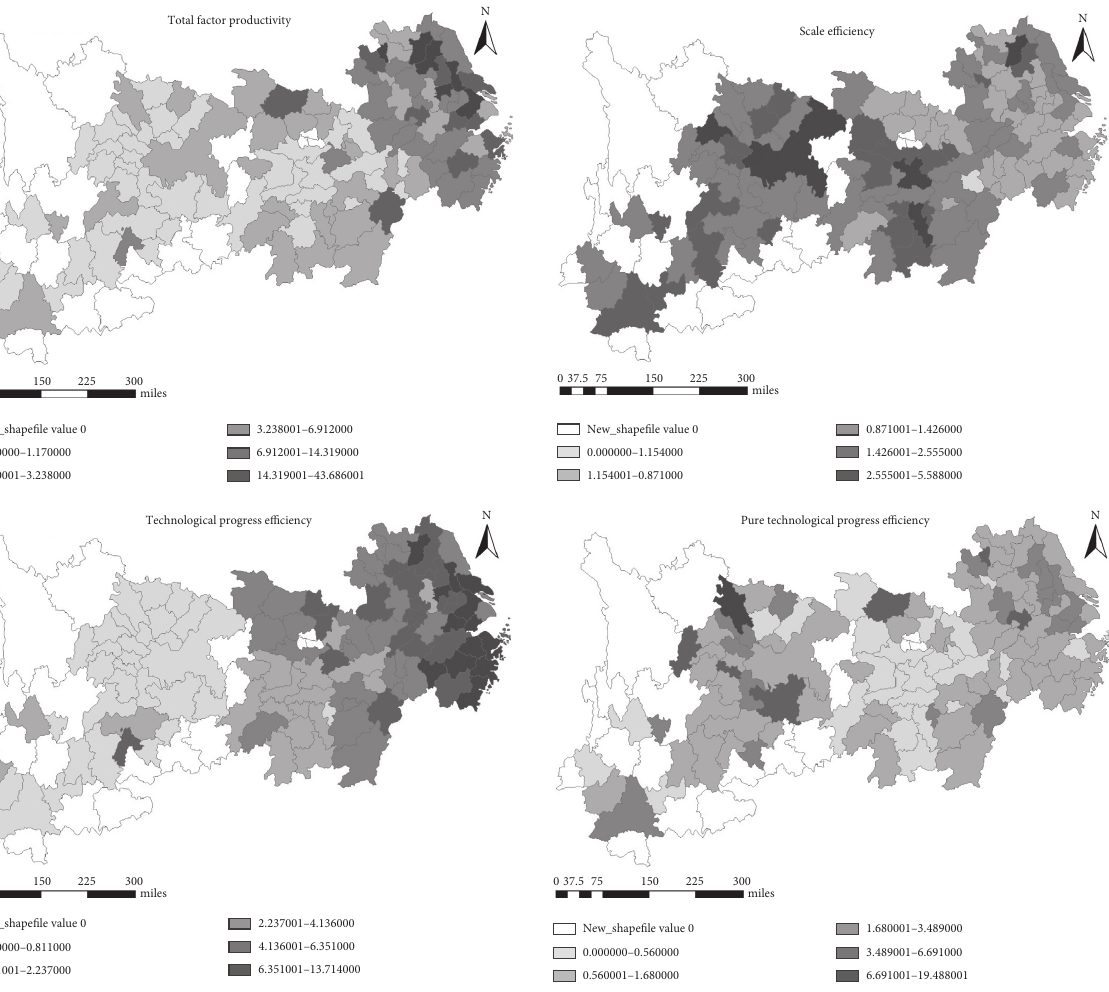
Figure 2: The Malmquist index analysis of Yangtze Economic Belt until Table 3: Innovation performance of groups in Yangtze Economic Belt.